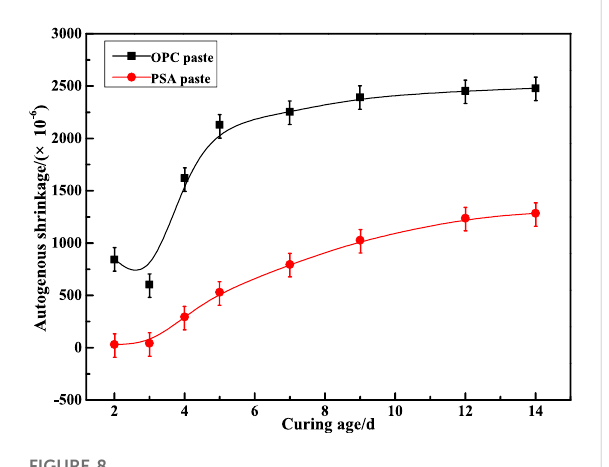
FIGURE 8 Volume soundness comparison of OPC and PSA paste samples.